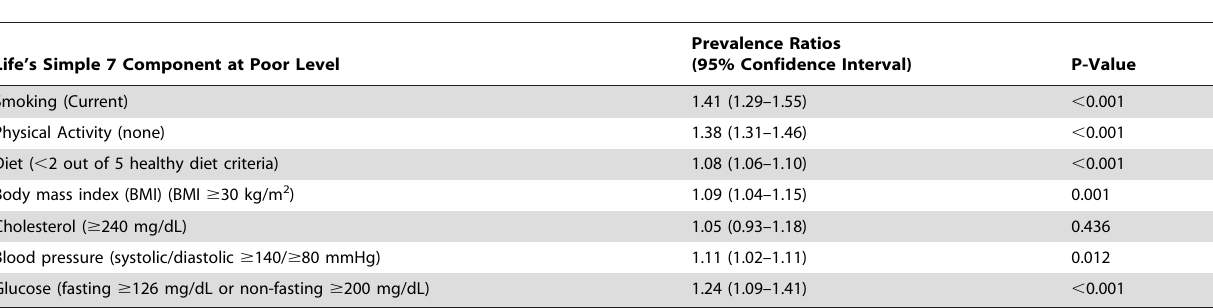
Table 3. Adjusted Prevalence Ratios for Poor Levels of Life’s Simple 7 Components for Participants With Compared to those Without Depressive